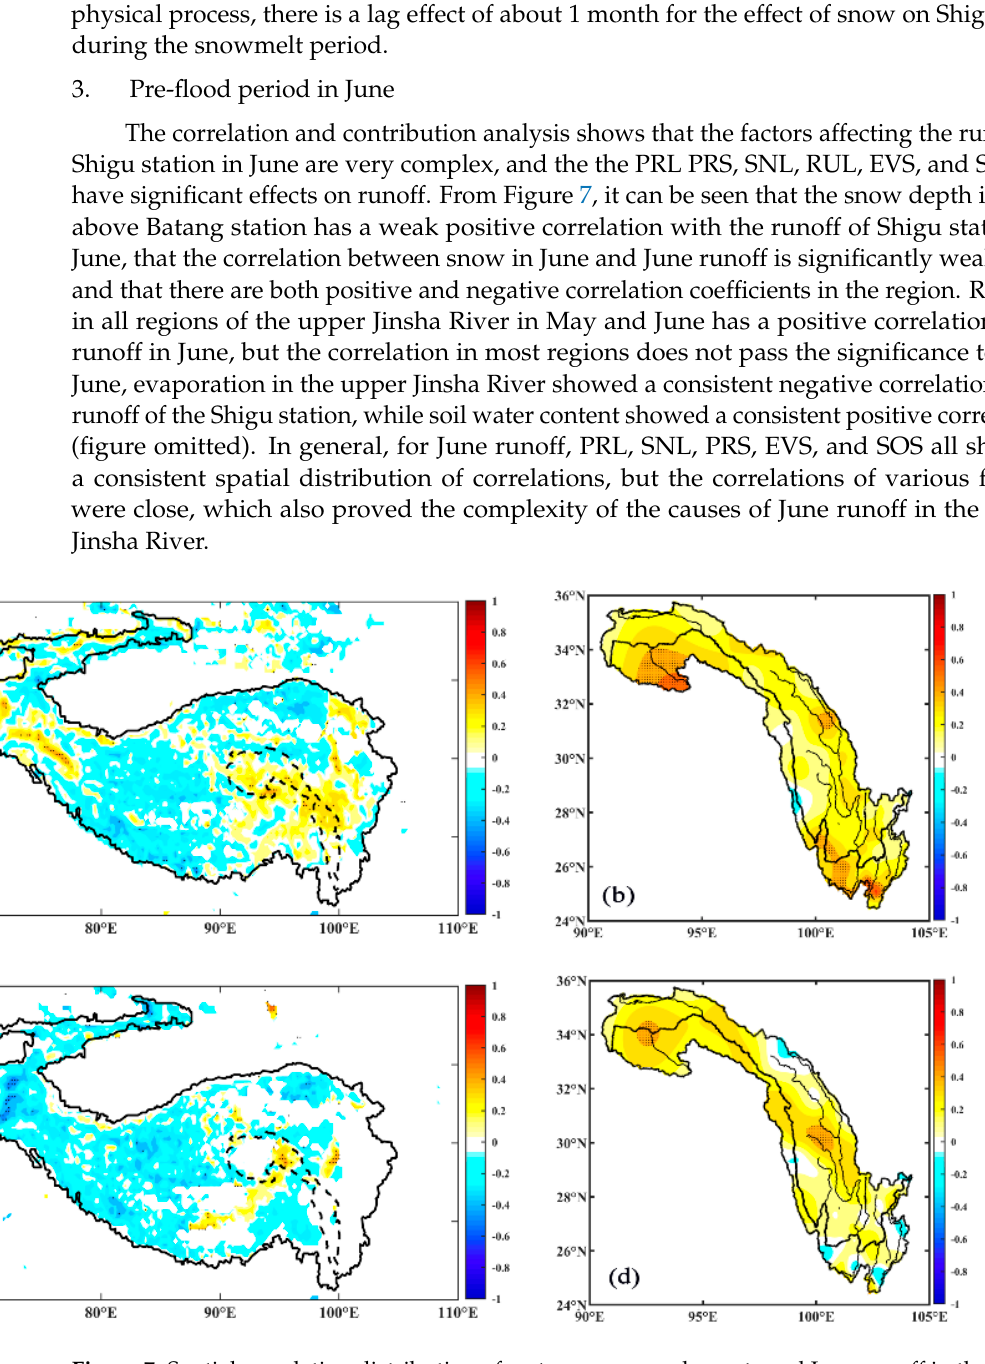
Figure 7. Spatial correlation distribution of water resources elements and June runoff in the upper Jinsha River (( a ) snow in the previous month; ( b ) rainfall in the previous month; ( c ) snow in the same period; ( d ) rainfall in the same period. Shading area means confidence level is above 0.01).